Question: Does the figure show an increasing or a decreasing trend?
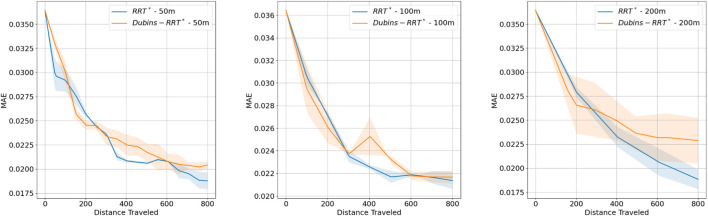
Answer: increasing